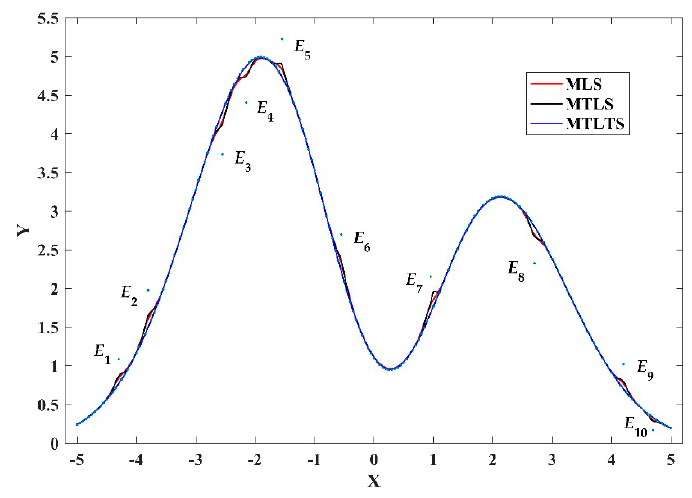
Figure 4. The fitting curves of three methods in Case 1.